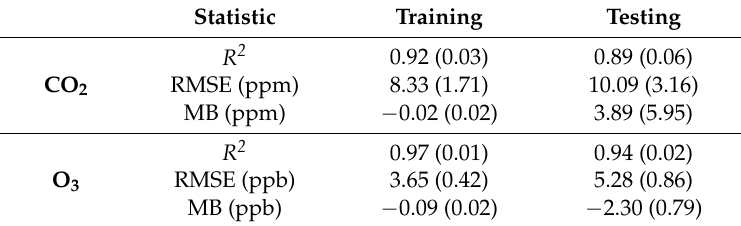
Table 1. Performance Statistics as Compared to Reference Datasets (Averaged for all